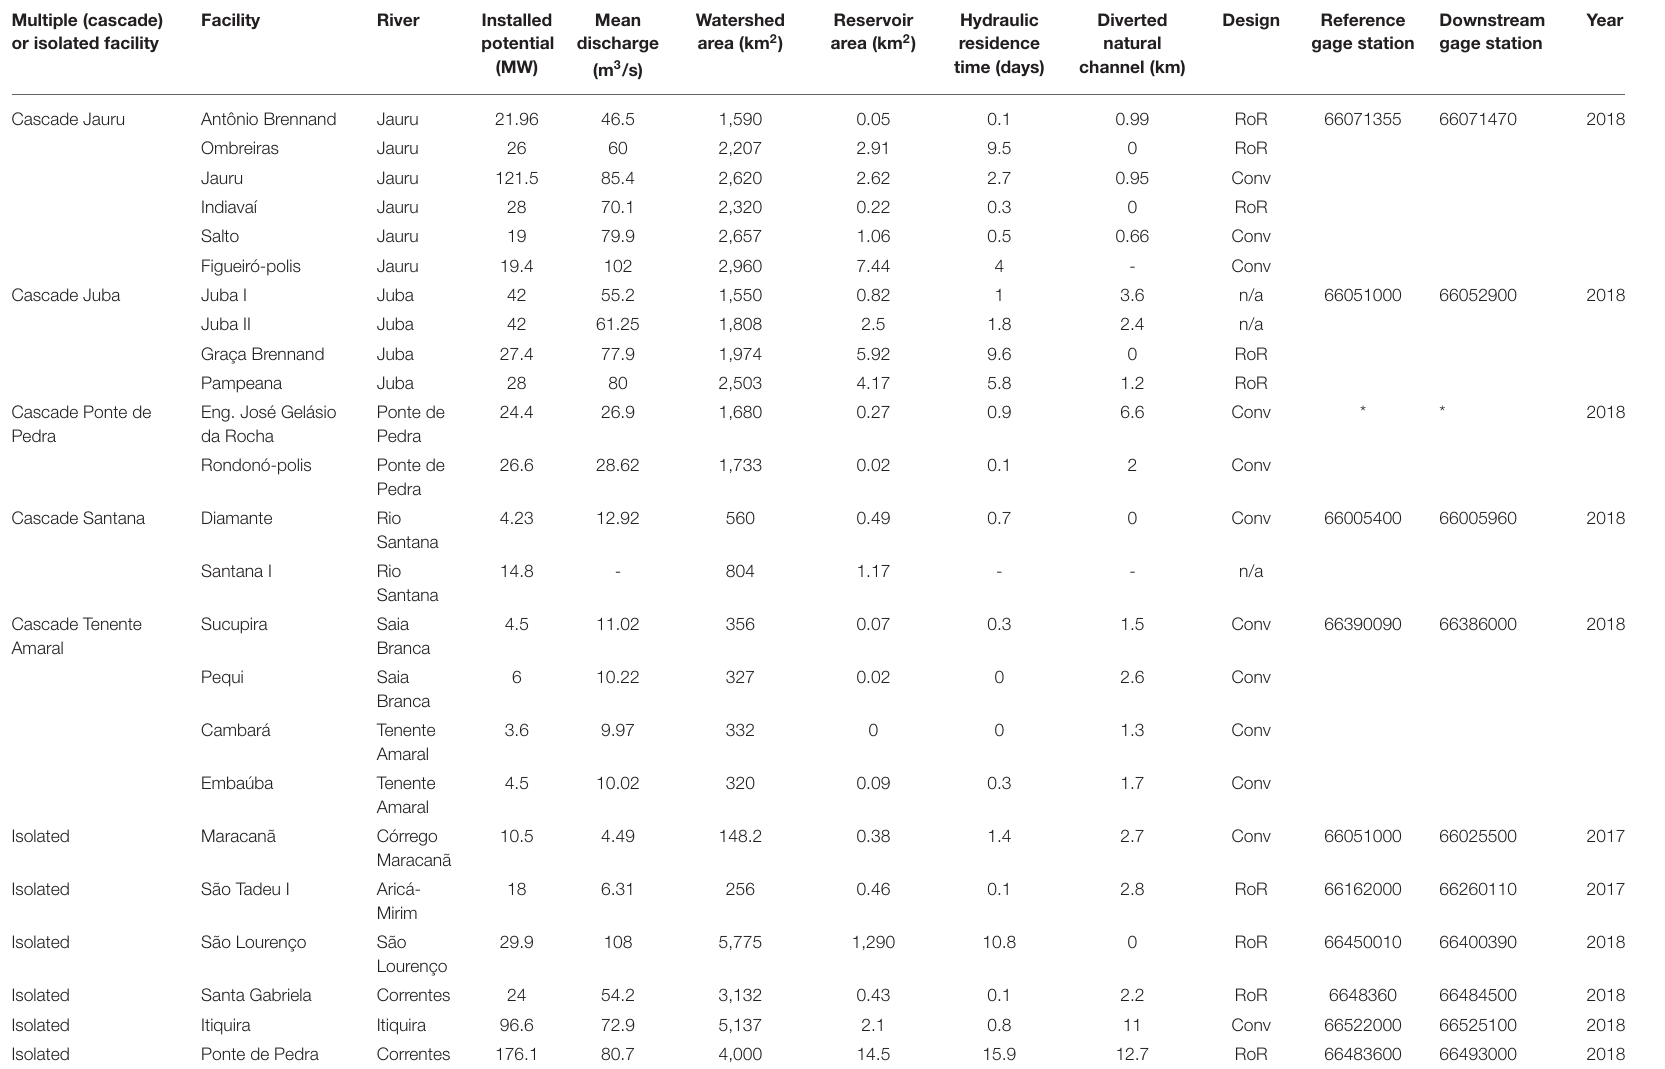
TABLE 1 | Locations and characteristics of the hydropower facilities and river discharge gage stations.